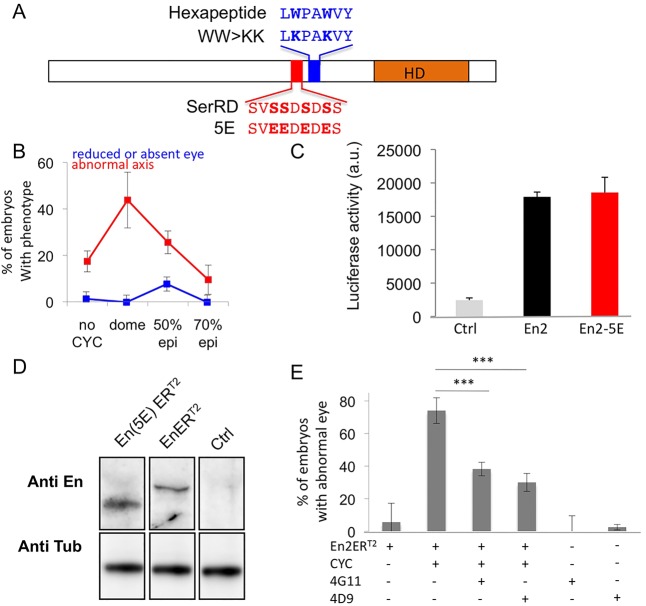
Engrailed gain of function involves the paracrine signalling properties of En. (A) Description of the two En2 mutants defective for paracrine signalling. (B) Diencephalon shortening requires En2 transfer. Activation of the En2(5E) transfer-deficient mutant following mRNA injection did not affect the size of the diencephalon. epi, epiboly. (C) Transcriptional activity of wild-type En2 and En2(5E). MAP1B:luciferase reporter plasmid was transfected into HeLa cells with an empty vector (ctrl) or together with the indicated constructs and analysed for luciferase activity after 24 h. a.u., arbitrary units. (D) In vivo ectopic expression of En proteins. Zebrafish embryos were injected at the one-cell stage with the indicated constructs. Following CYC addition at 50% epiboly, cell extracts from 90% epiboly embryos were prepared and analysed by western blotting with polyclonal (anti-En) or monoclonal (anti-tub) antibodies. (E) Inhibition of En2 transfer rescued the phenotype of En2 activation. Zebrafish embryos were injected at the one-cell stage with mRNA encoding En2ERT2 and injected again in the extracellular space at the blastula stage with two different anti-En antibodies. CYC was added at 50% epiboly in the water bath to activate the protein. Eye phenotypes were scored at 2 dpf. The error bars represent statistical errors. ***P<0.001.